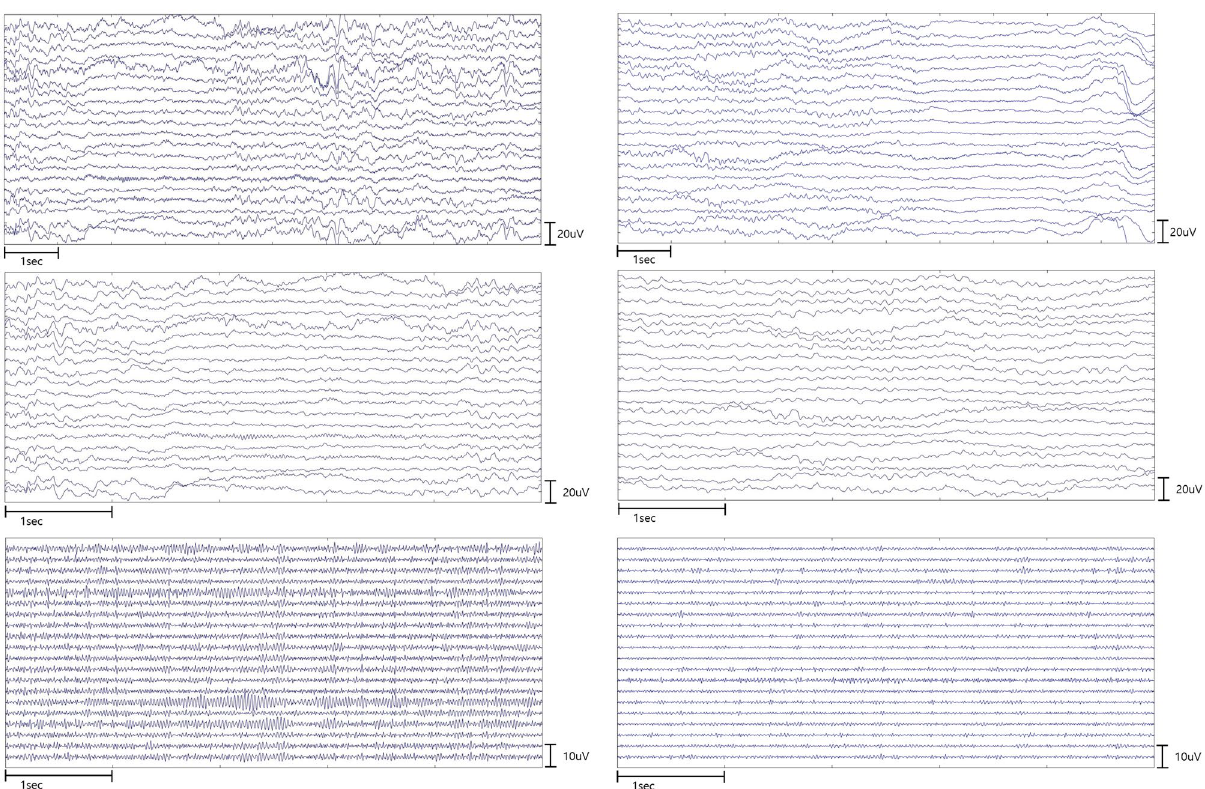
Figure 1. Representative visual analysis of raw data. The visual analysis could not differentiate poor and good neurological outcome. Example of EEGs from patients with poor (left panel) and good (right panel) neurological outcomes. Top—EEG filtered with a 0.5-Hz high-pass filter with a sensitivity of 10 μV/mm. Middle—EEG filtered with a 14-Hz high-pass filter with a sensitivity of 5 μV/mm. Bottom—EEG filtered with a 30-Hz high-pass filter with a sensitivity of 5 μV/mm. The alpha-PSD values of this epoch in patients with poor (left panel) and good (right panel) neurologic outcomes were 0.06 and 3.07,